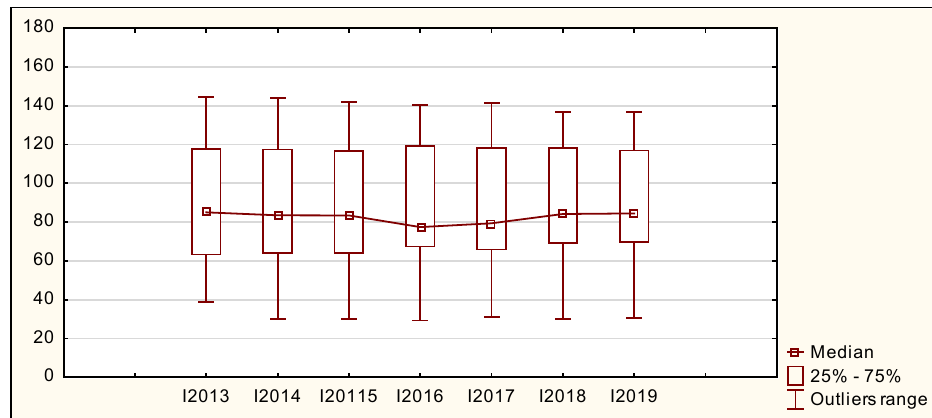
Figure 2. Box plot of the Summary Innovation Index for the EU countries in the years